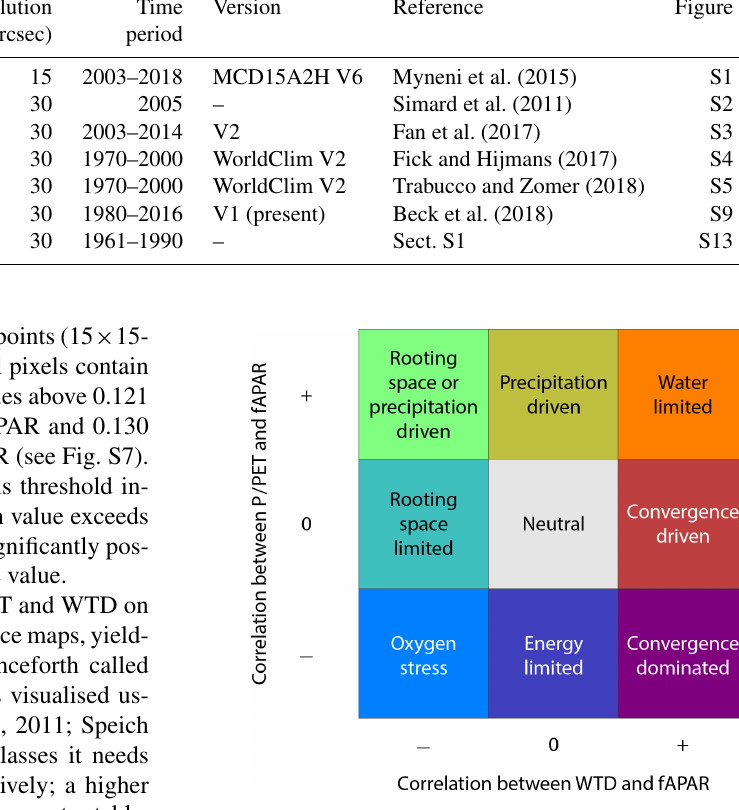
Figure 2. Ecohydrological classes and their interpretation of the combined spatial correlation maps between respectively WTD, P/ PET and fAPAR. The figure is used as the legend of Figs. 3–7.